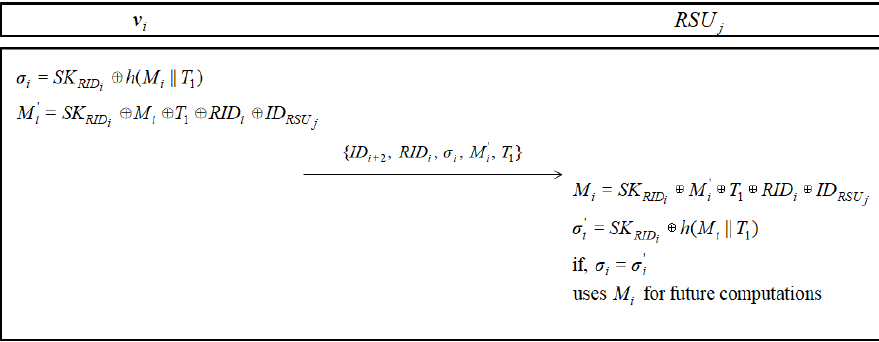
Figure 4. Message signature phase of Limbasiya et al.’s